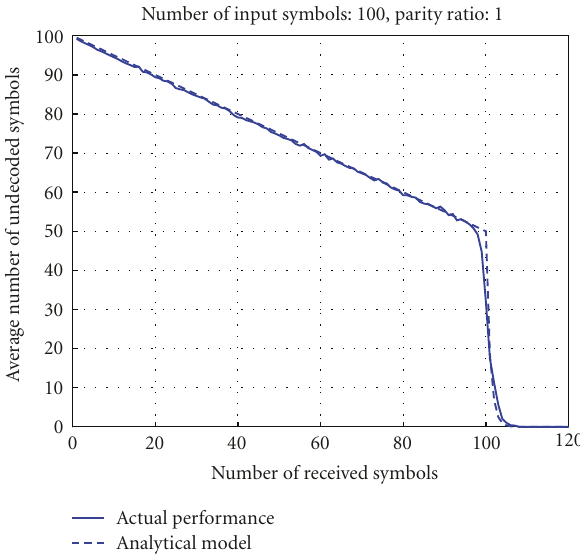
Figure 13: Performance curve of Raptor coding, N i = 100, ρ = 1 . 0 .